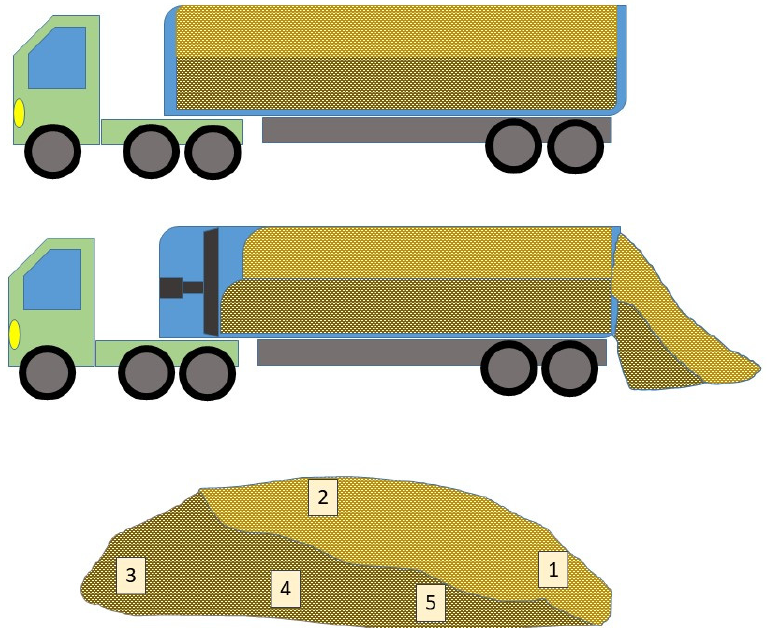
Figure 1. Location of the predefined sampling areas in the pile of unloaded wood chips (side view).